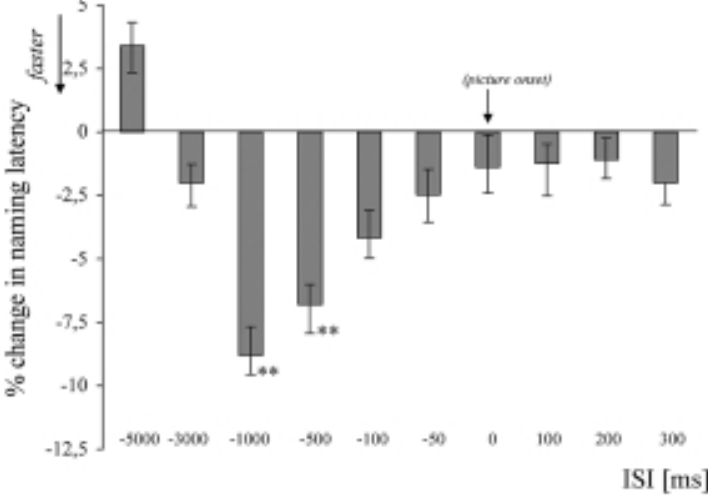
Fig. 3. Pooled results of all single-pulse TMS experiments [41] are shown. Interestingly a general unspecific reduction of naming latency was seen independent of the ISI, however a significant reduction ( p < 0 . 05 ) of naming latencies was observed only if TMS preceded picture naming by 500 or 1000